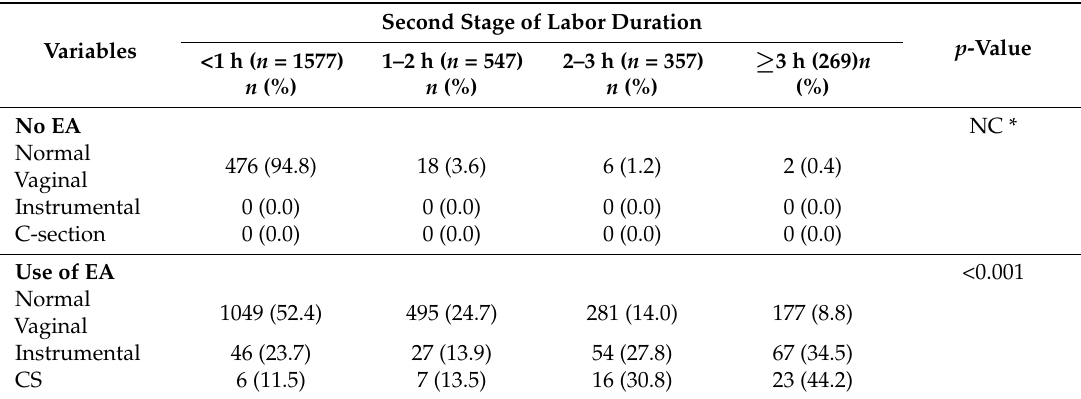
Table 3. Relation between the use of EA, the type of delivery and the delivery duration in pregnant women who reach the second stage of labor.